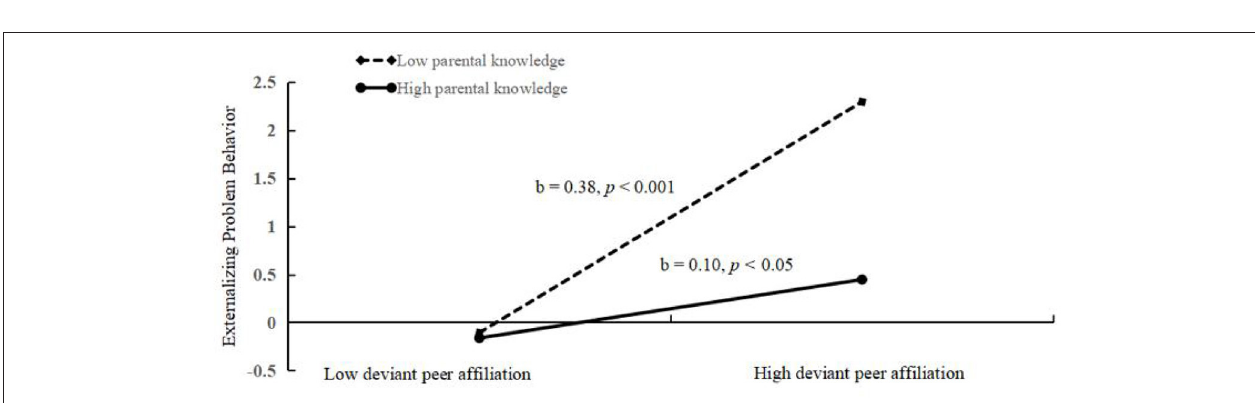
FIGURE 8 | Association between deviant peer affiliation and externalizing problem behaviors at higher and lower levels of adolescent parental knowledge (After add covariate: school